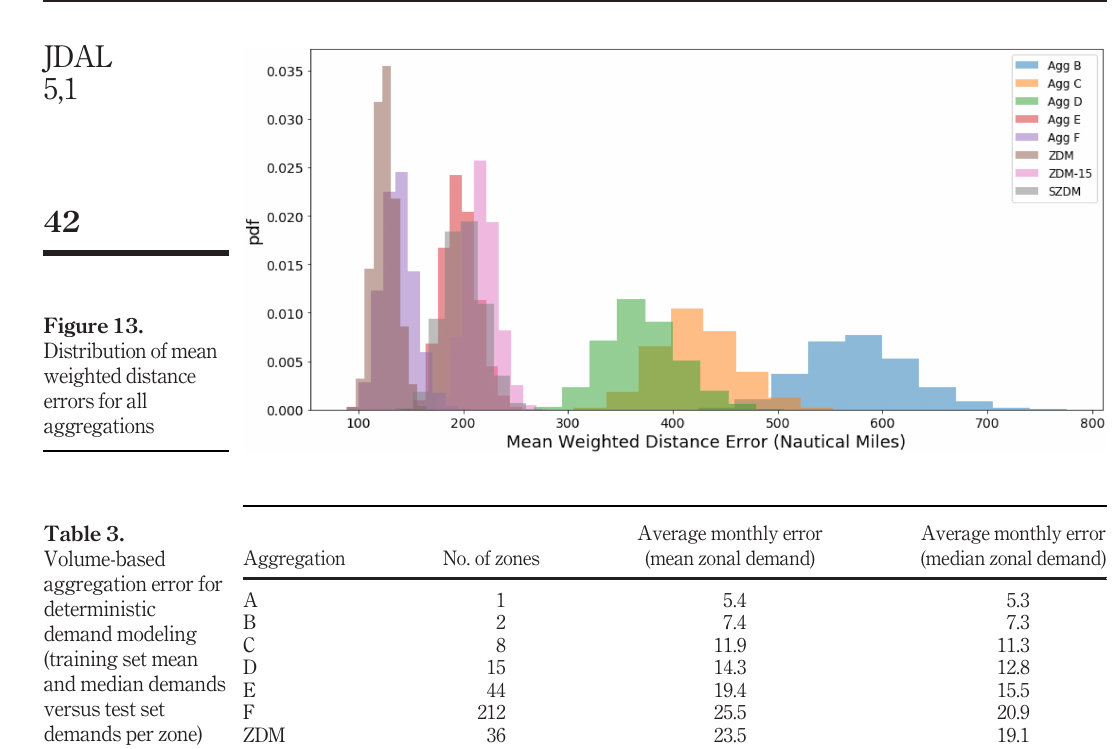
Table 3. Volume-based aggregation error for deterministic demand modeling (training set mean and median demands versus test set demands per zone)